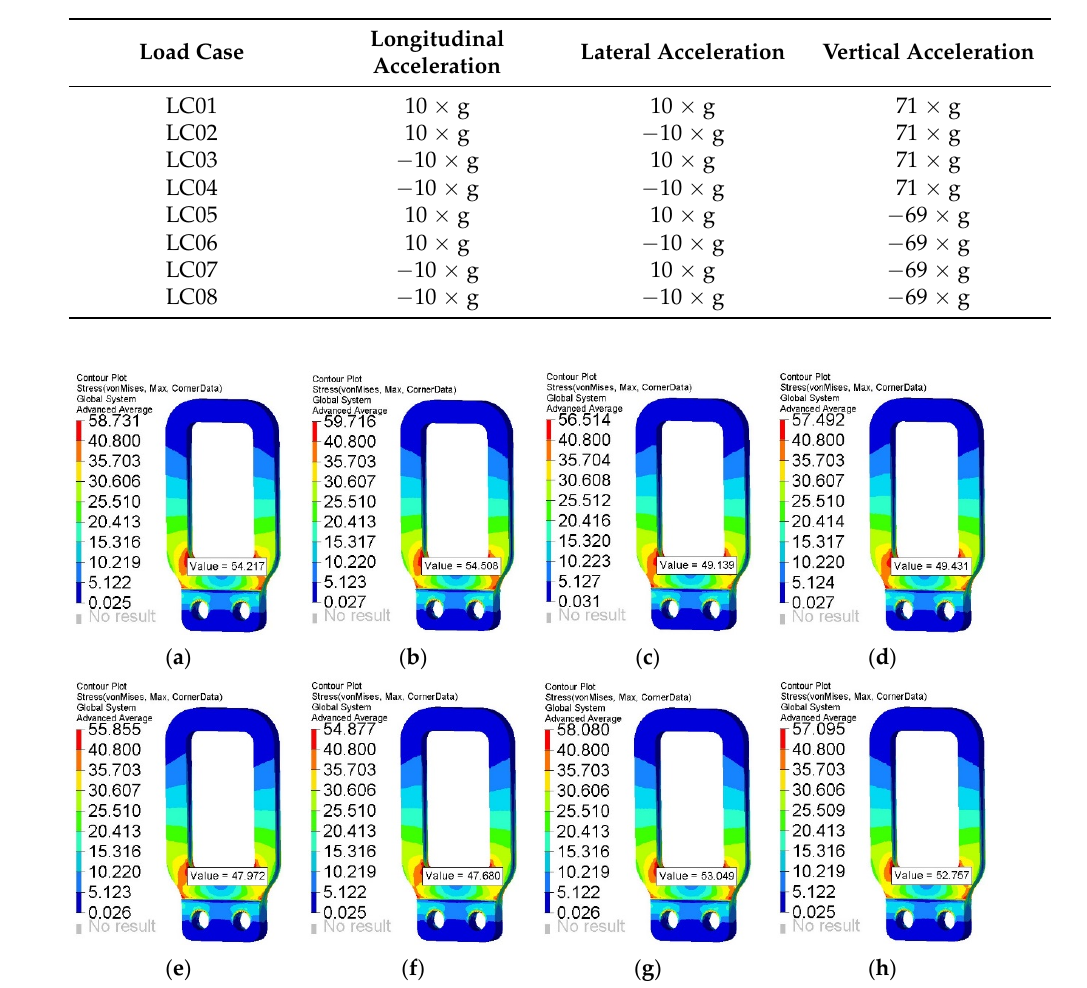
Figure 12. Stress contour plots of the wheelset lifting mechanism: ( a ) LC01; ( b ) LC02; ( c ) LC03; ( d ) LC04; ( e ) LC05; ( f ) LC06; ( g ) LC07; ( h ) LC08.